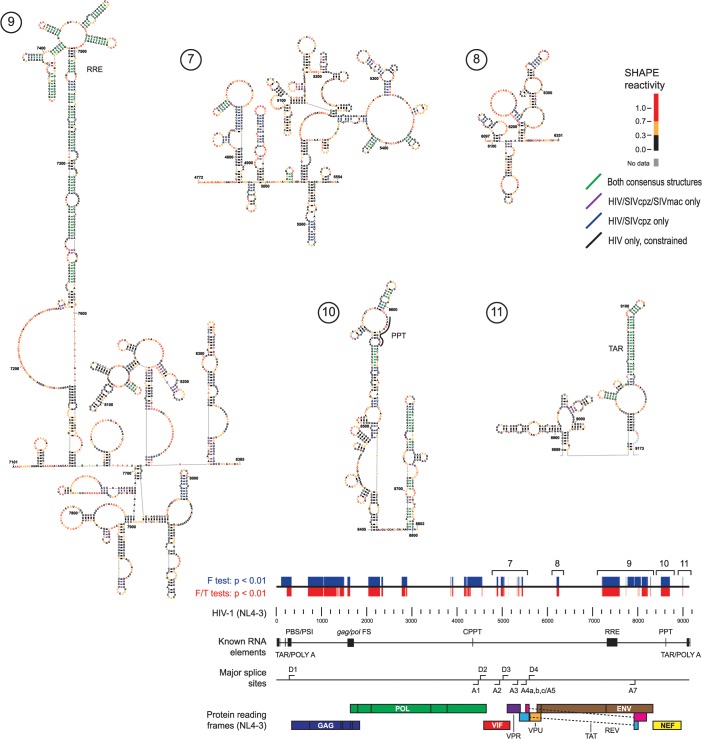
Secondary structure models for five structurally conserved elements in the 3' half of HIV-related RNA genomes.Secondary structures are shown for the final constrained HIV-1 secondary structure model. Other figure annotations are described in the Fig 3 legend.